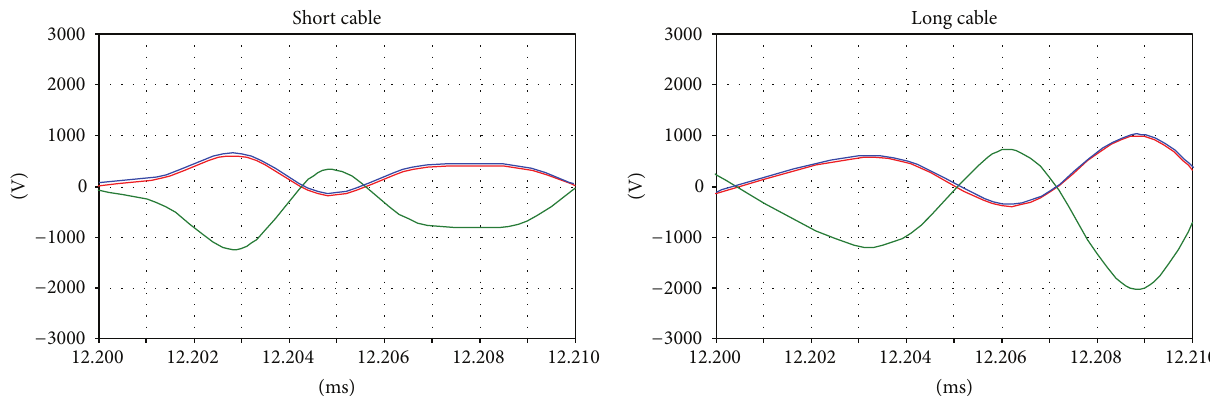
Figure 19: Details of the transient voltages in the tap coil during the